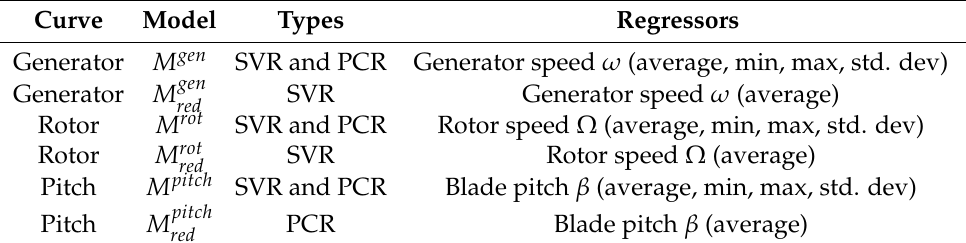
Table 2. The structure of the